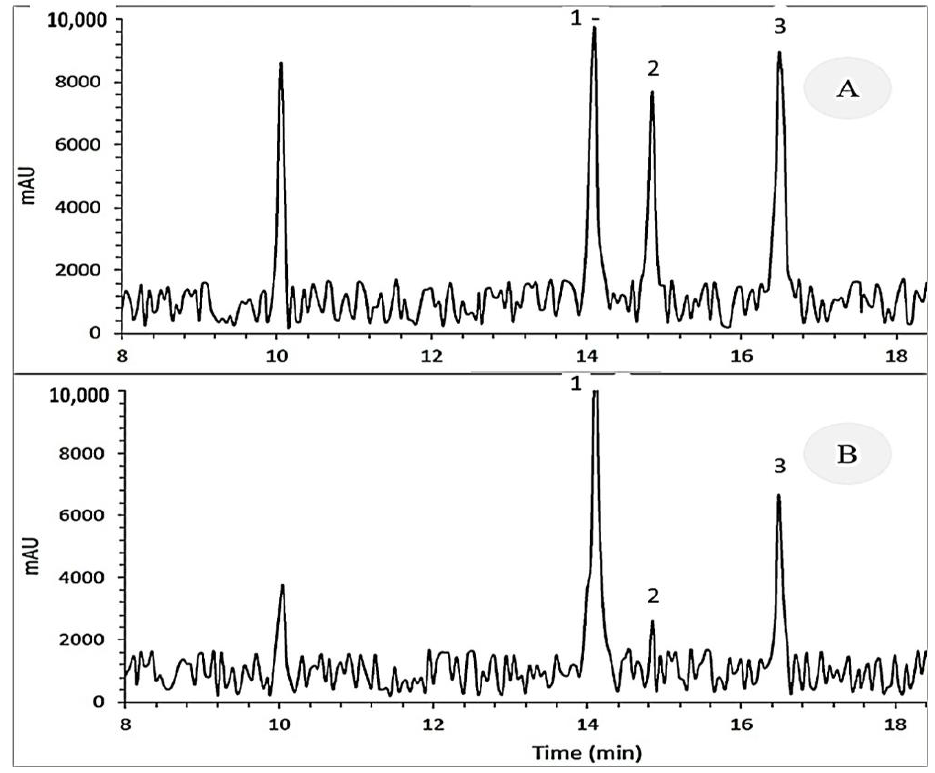
Figure 2. HPLC representative chromatogram of ( A ) the standard extracts and ( B ) seed extracts of Cuscuta campestris developed on various hosts. 1. Quercetin (retention time: 4.11 min); 2. Bergenin (retention time: 14.85 min); 3. Kaempferol (retention time: 16.49